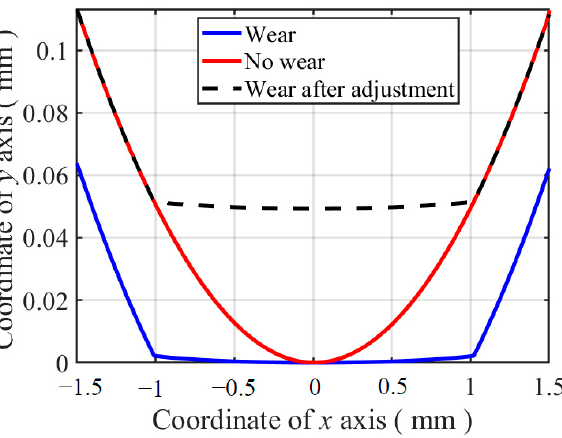
Figure 13. Profiles of the cylinder before and after fretting wear and the adjusted wear profile.